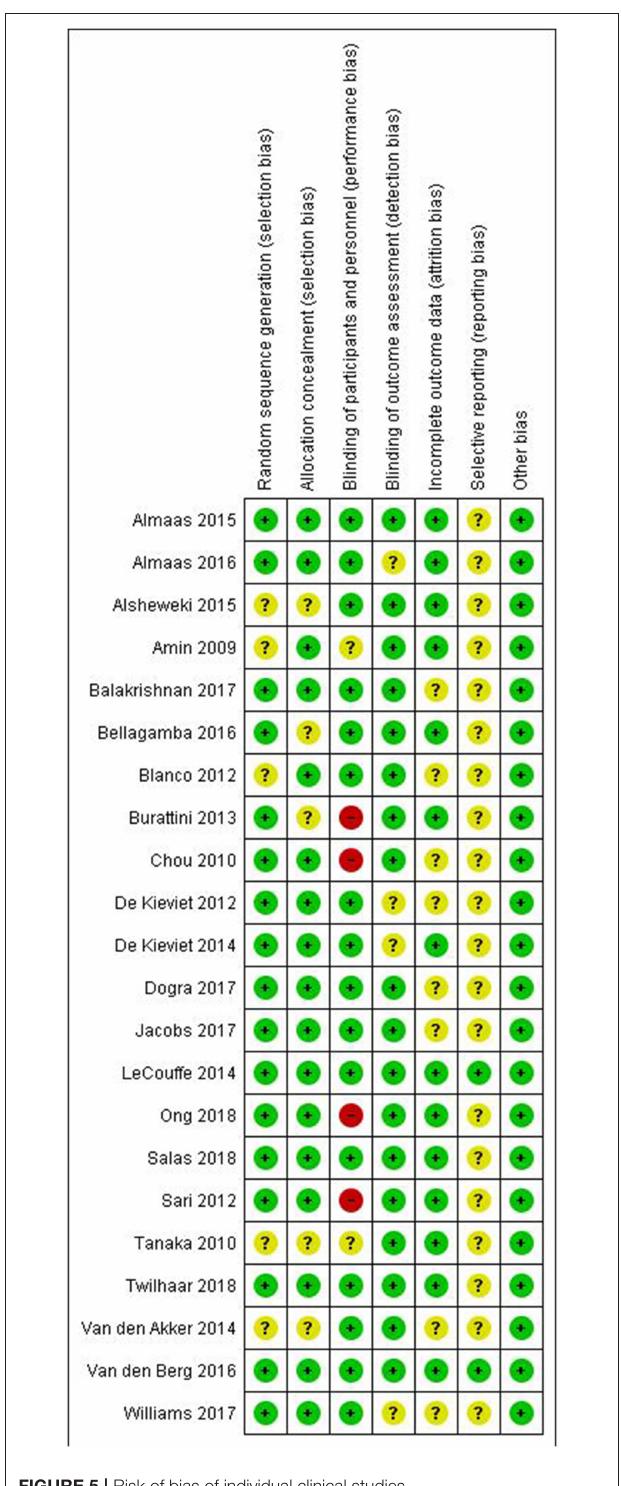
life and increased brain volumes at 8 years. However, at 13 years of age, no positive effect of glutamine was found on neurodevelopmental outcome. Working memory and